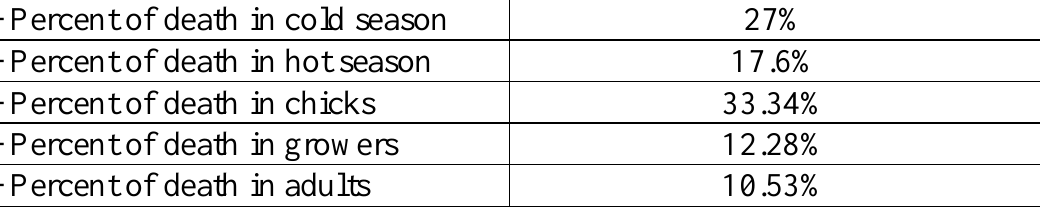
Table (3): Mortality rate (%) by age and